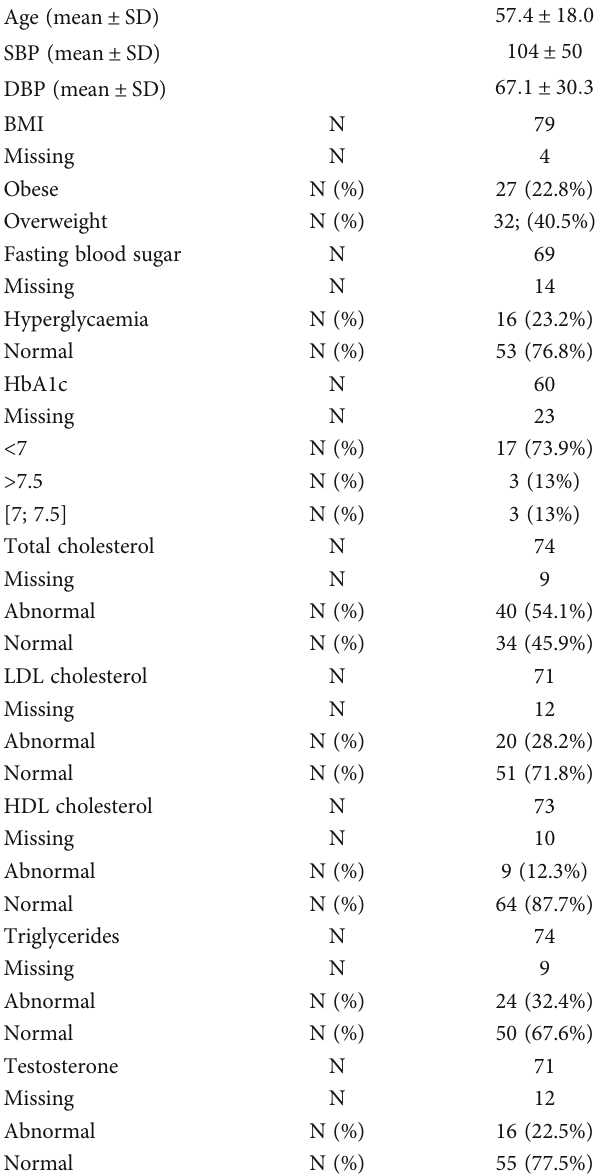
Table 1: Characteristics and laboratory parameters of the study population. The laboratory values of patients were classi fi ed as “ normal ” or “ abnormal ” according to the reference values of each